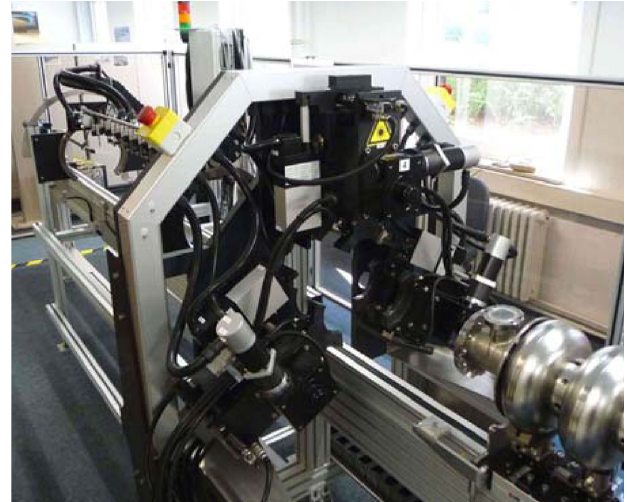
assembled.FIG. 16. (Color) Entire cavity tuning machine with machine housing. The door at the cavity insert position is